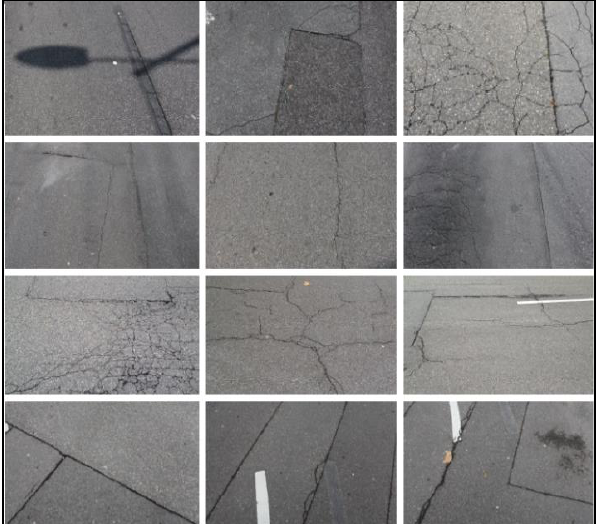
Figure 3. Some image data containing linear, block and alligator cracks The matching for all variants (LF, HPF and LBP) is carried out on the resolution levels which vary from the coarsest level (1/8) and ascends to the highest image resolution (1/1). The down- sampling enables detection of cracks with different widths. Figure 4 shows the detected crack pixels using LF variant on the four different resolutions.